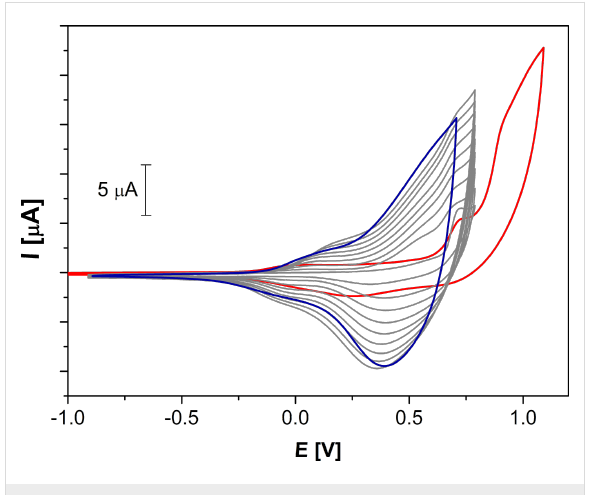
Figure 3: Cyclic voltammogram of bithienyl-triazole 14 in dichloromethane/TBAPF 6 (0.1 M) versus Fc/Fc + at 100 mV s − 1 (red: monomer 14 , gray: during polymerization, blue: polymer